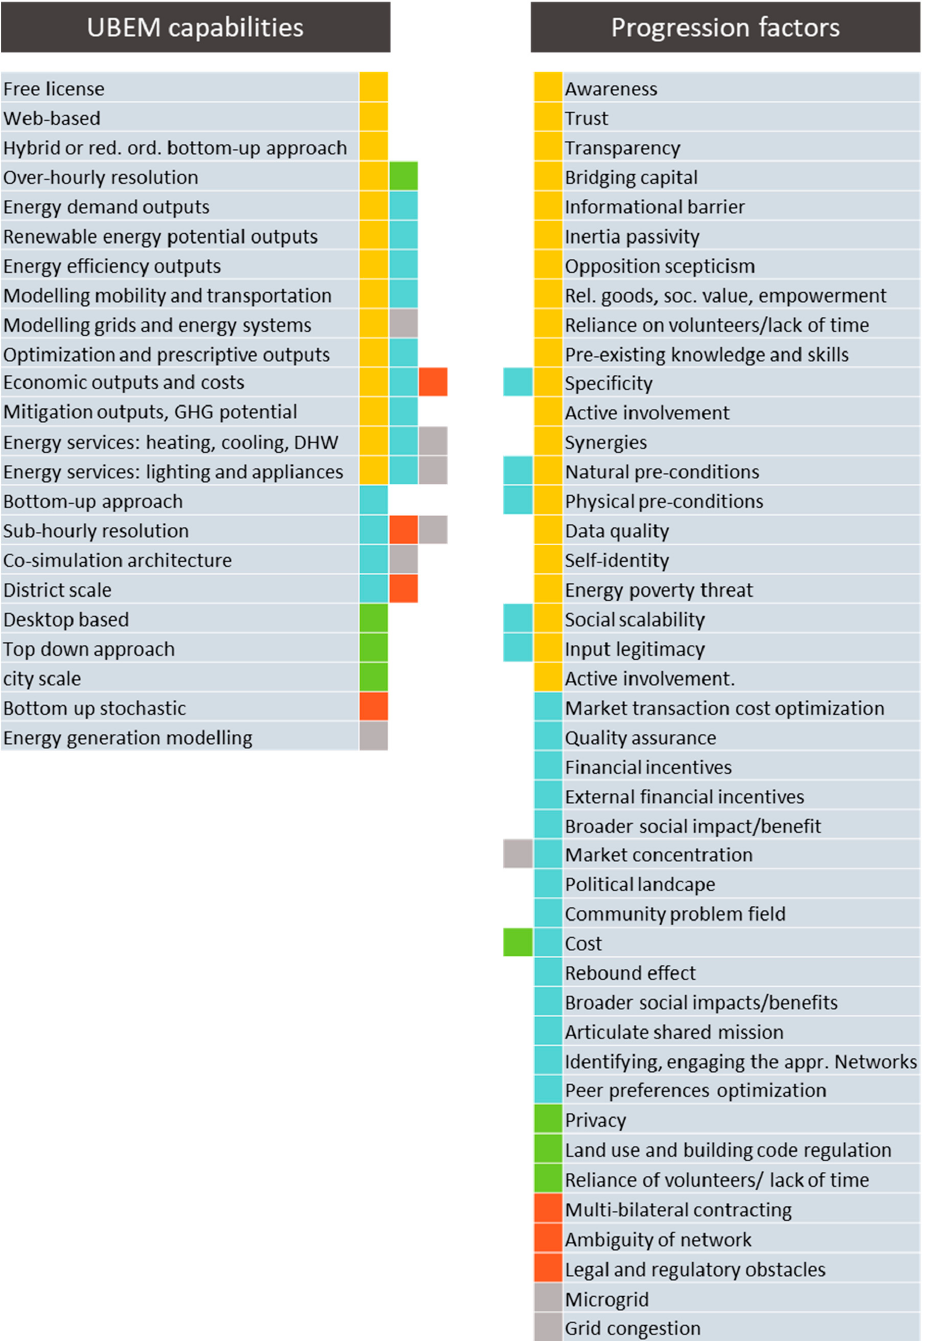
Figure 23. UBEM-EC matchmaker: bipartite graph pairing UBEM capabilities to progression factors by colour.